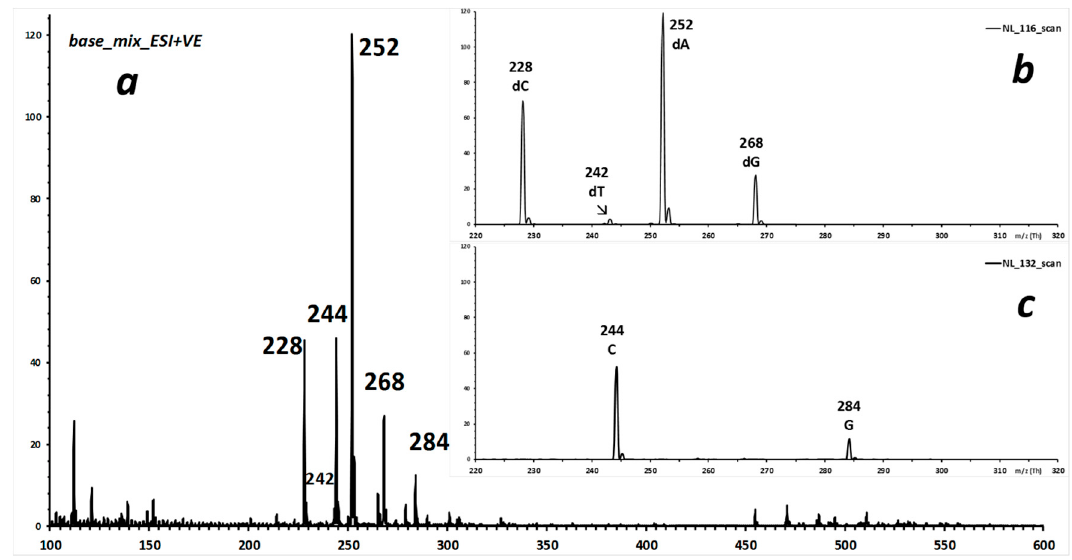
Figure 5. Source spectrum of a mixture of dA, dC, dG, dT, C and G (mean of 20 1-s scans, infusion mode). Inserts: consecutive 1-s alternate NL-scans of 116 Da (upper, selective for deoxy-ribonucleosides) and 132 Da (lower, selective for ribonucleosides).